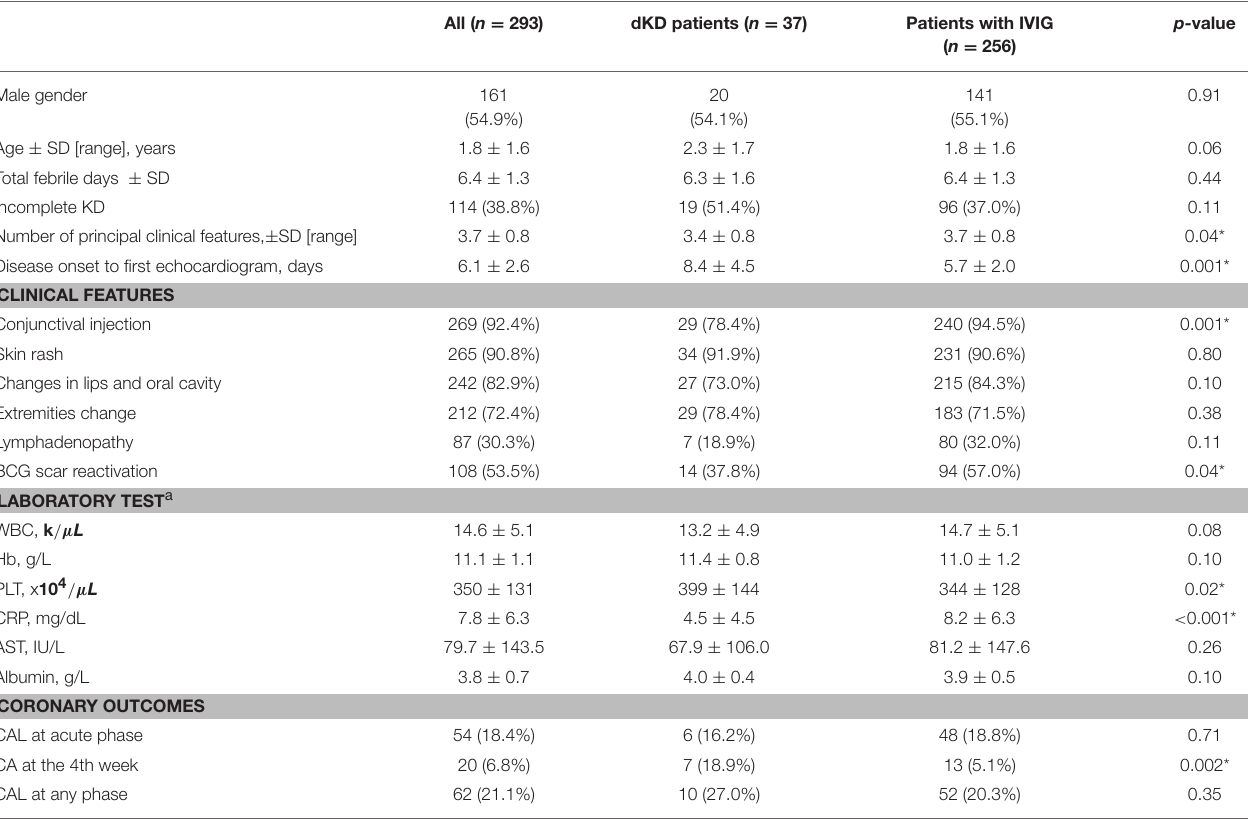
TABLE 1 | Clinical and laboratory features of KD patients with fever from 5 to 10 days.